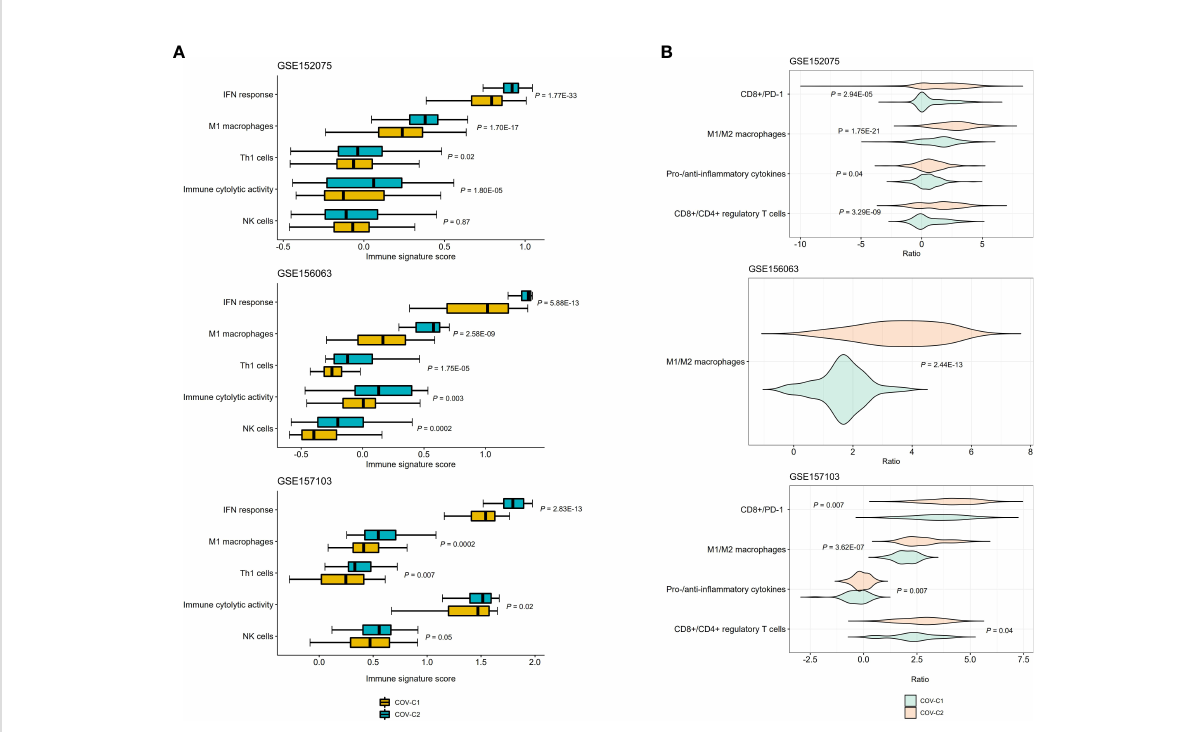
FIGURE 4 Comparisons of antiviral immune signatures between COV-C1 and COV-C2 patients. (A) COV-C2 patients likely have higher enrichment scores of antiviral immune signatures than COV-C1 patients. One-tailed Mann – Whitney U test P -values are shown. (B) COV-C2 patients have signi fi cantly higher ratios of immunostimulatory over immunoinhibitory signatures. Two-tailed student ’ s t test P -values are